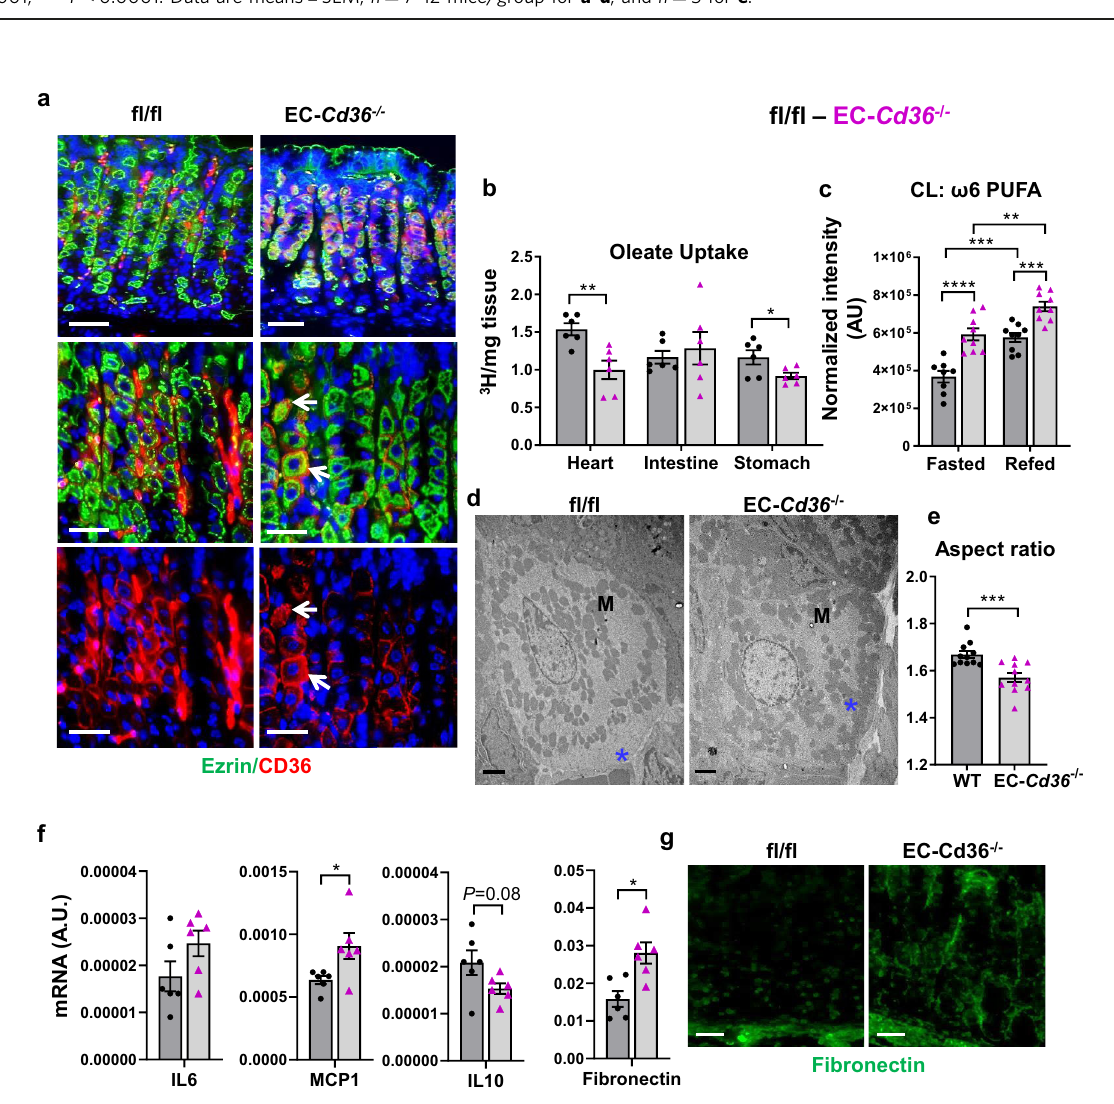
Fig. 7 Deletion of Cd36 in endothelial cells (EC) reduces corpus fatty acid uptake and recapitulates morphological abnormalities of germline Cd36 − / − mice. a Gastric sections from fl oxed controls (left panels) and EC- Cd36 -/- mice (right panels) showing absence of CD36 expression in the gastric endothelium and CD36 expression in parietal cells (PCs) (white arrows, bottom right). Scale bars: 50 µ m (top) and 20 µ m (bottom) panels. b Corpus uptake of oleic acid is reduced in EC- Cd36 − / − mice. 16 h fasted 4-month-old mice were given a retro-orbital injection of [ 3 H]oleic acid and tissues collected for measuring radioactivity 5 min later. c Sum of cardiolipin species enriched with ω 6 PUFA d Transmission EM showing EC- Cd36 − / − PCs lack the mitochondria ( “ M ” )-free area near the plasma membrane bordering capillaries (right panel). Scale bar: 2 µ m . e Quanti fi cation of mitochondrial circularity and aspect ratio (major/minor axis). f mRNA expression of gastric hormones, fi bronectin, and in fl ammatory markers in corpus of EC- Cd36 − / − mice. g Fibronectin staining (green) in corpus of control and EC- Cd36 − / − mice, scale bar: 50 µ m. Signi fi cance was calculated using a two-sided unpaired t test or a two-way ANOVA followed by post hoc tests by Sidak multiple comparisons ( c ). * P < 0.05, ** P < 0.01, *** P < 0.001, **** P < 0.0001. Data are means + SEM. b n = 6; c n = 8 – 9; e n = 1500 mitochondria from 11 PCs/genotype; f n =